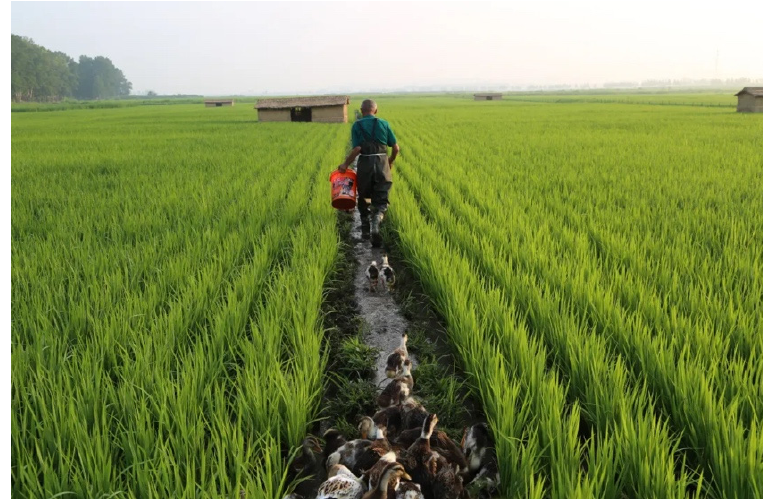
Figure 2. A picture obtained in the study area shows a typical rice field boundary bank, around 1 m in width.